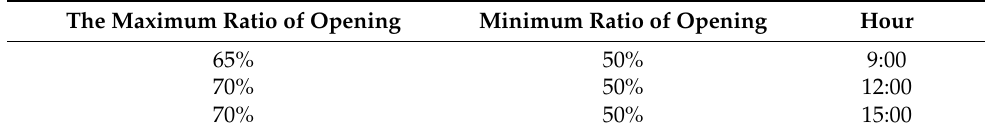
Figure 21. Choosing the optimal conditions for different hours on 21st June. Table 5. Best values for the opening ratio of shading device on 21st June.